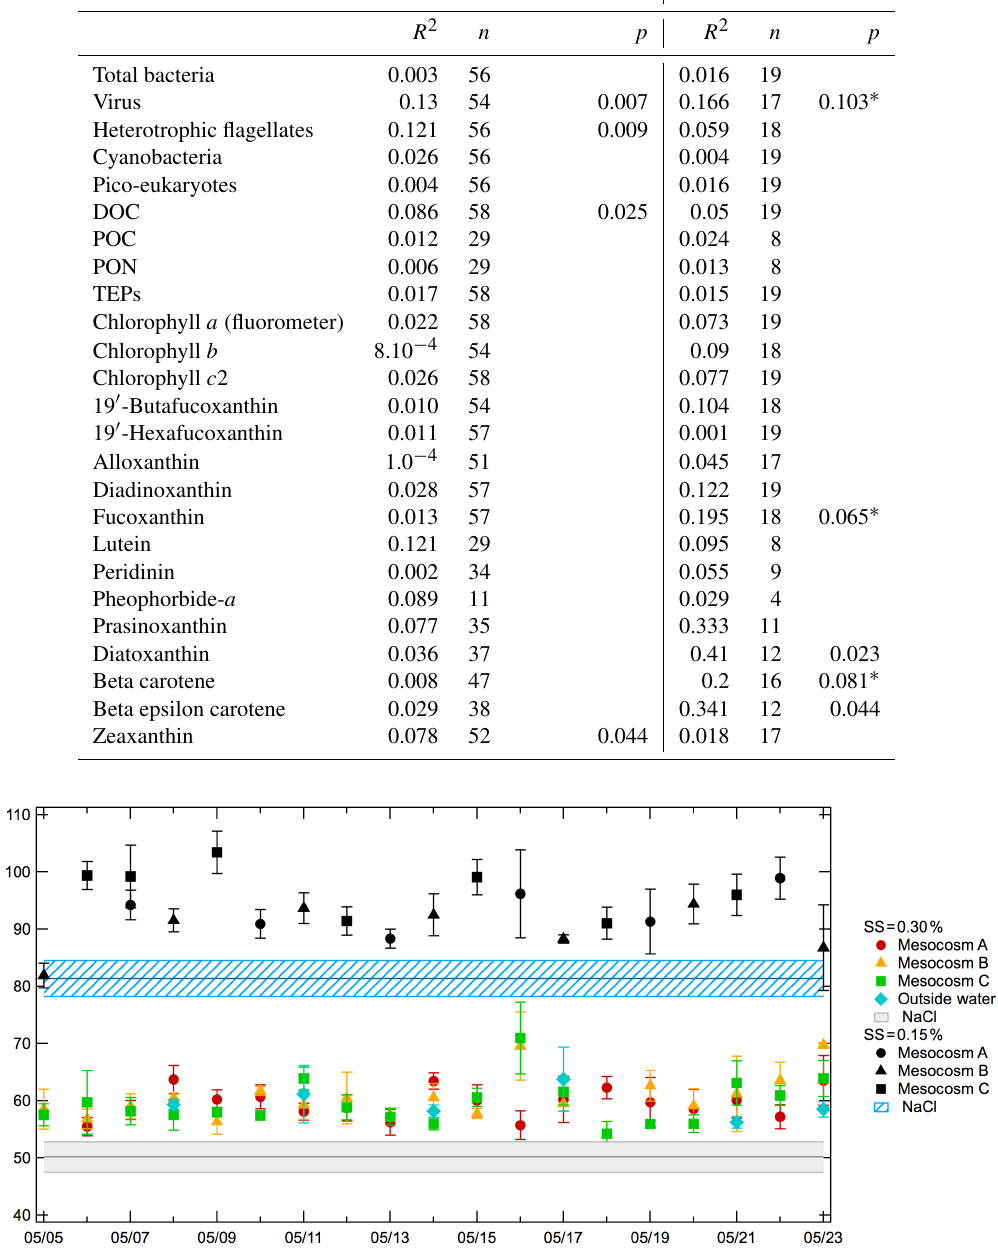
Figure 7. Activation diameters at SS = 0.30% and SS = 0.15%. The shaded and striped areas indicate the NaCl activation diameters at each given supersaturation as a direct comparison to the seawater